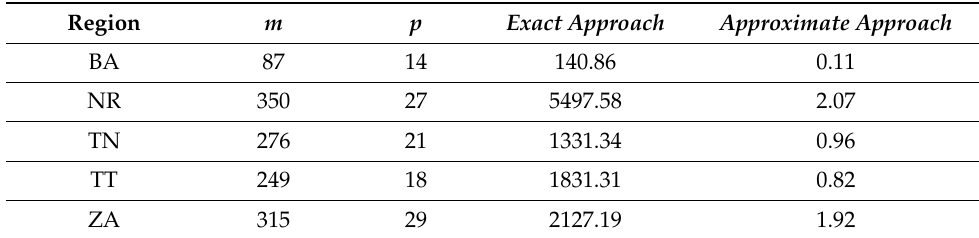
Table 4. Comparison of average computational times in seconds of the exact and approximate approaches to Pareto front